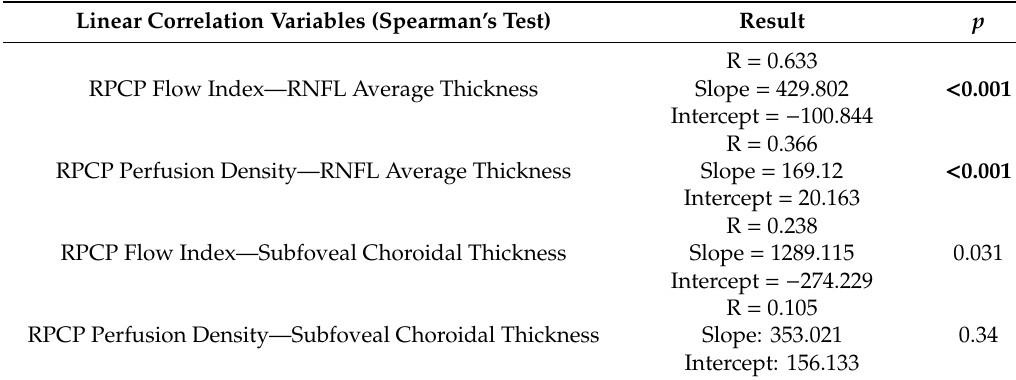
Table 5. Spearman’s Test linear correlation between continuous variables of